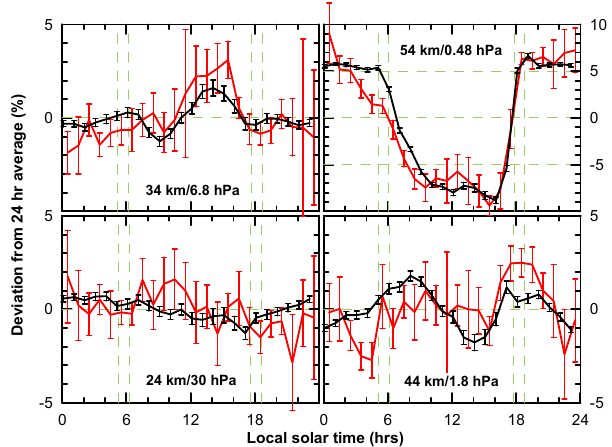
Figure 10. Ozone values as measured by SMILES (red line) and MWR (black line) for each hour of the day, normalized to the cor- responding average of measurements over all 24h. The SMILES measurements were taken over a zonal band from 15 ◦ to 25 ◦ N. The dashed green vertical lines indicate sunrise and sunset times at 20 ◦ N. Two standard deviation statistical error estimates are shown as error bars. See text for other